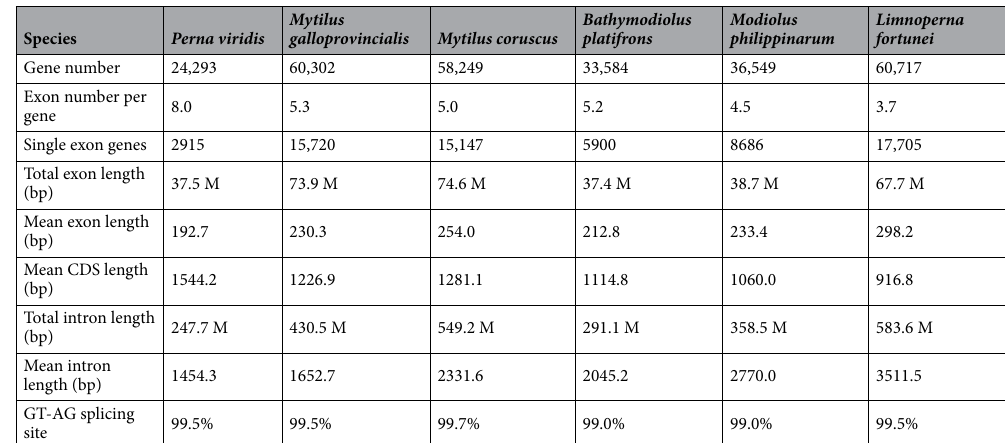
Table 2. Comparison of the gene annotation statistics of the green mussel Perna viridis in the present study with those of other Mytilid mussels reported previously.